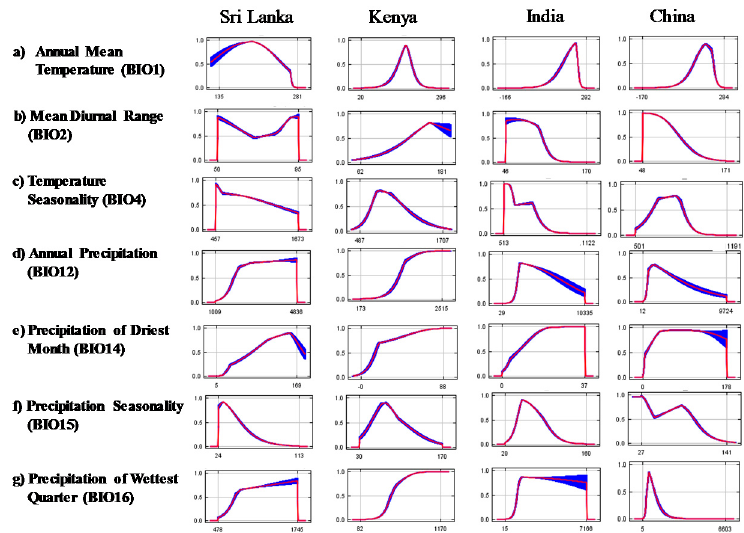
Figure 1. The marginal response curves of seven selected bioclimatic variables including in tea habitat distribution models of four tea-producing countries. Note. The habitat suitability of tea of four countries changes in varying degrees with ( a ) annual mean temperature (BIO1), ( b ) mean diurnal range (BIO2), ( c ) temperature seasonality (BIO4), ( d ) annual precipitation (BIO2), ( e ) precipitation of direst month (BIO14), ( f ) precipitation seasonality (BIO15), and ( g ) precipitation of wettest quarter (BIO16).